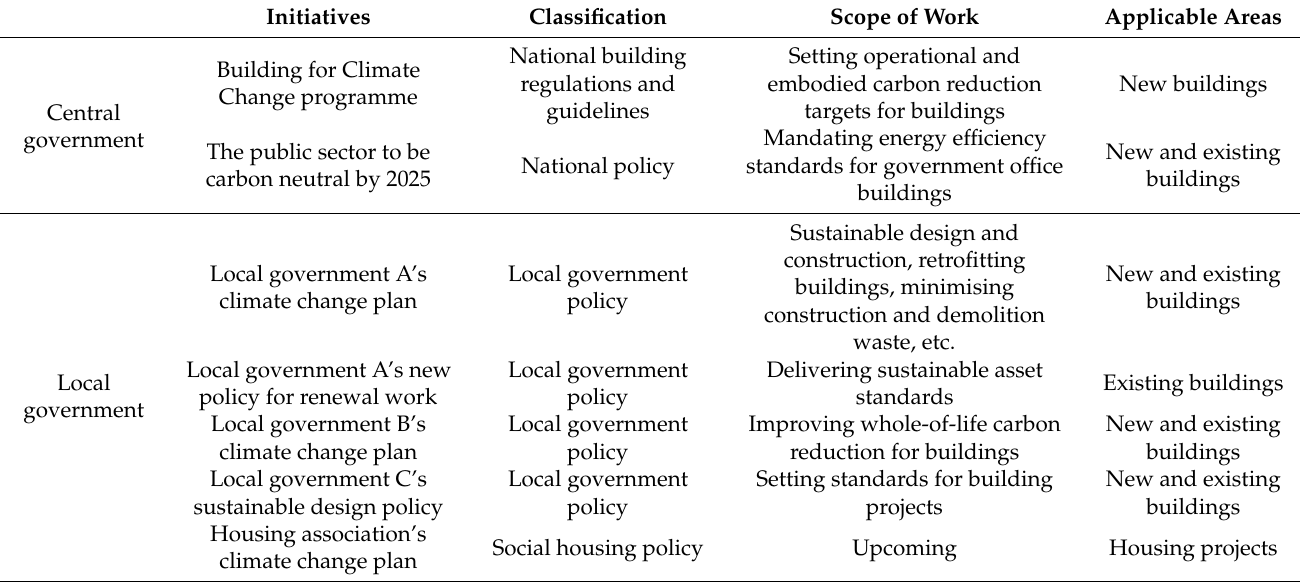
Table 2. A summary of government initiatives towards net-zero carbon buildings in New